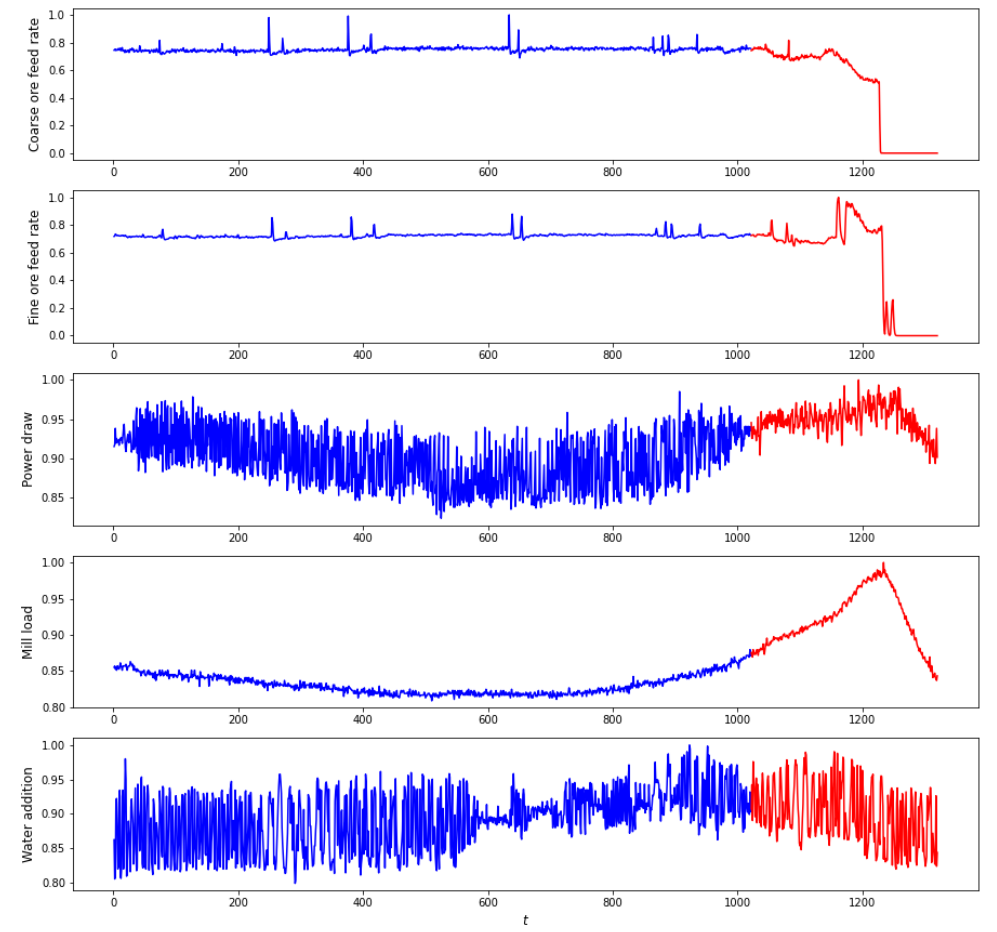
Figure 23. Scaled multivariate grinding circuit data. Circuit operational state changes from NOC (blue) to overloaded mill (red), as logged by the expert mill controller.